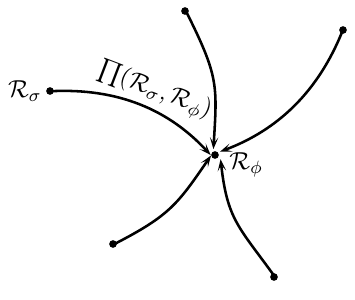
Figure 3. Incoming flow of Figure 3: Incoming flow of